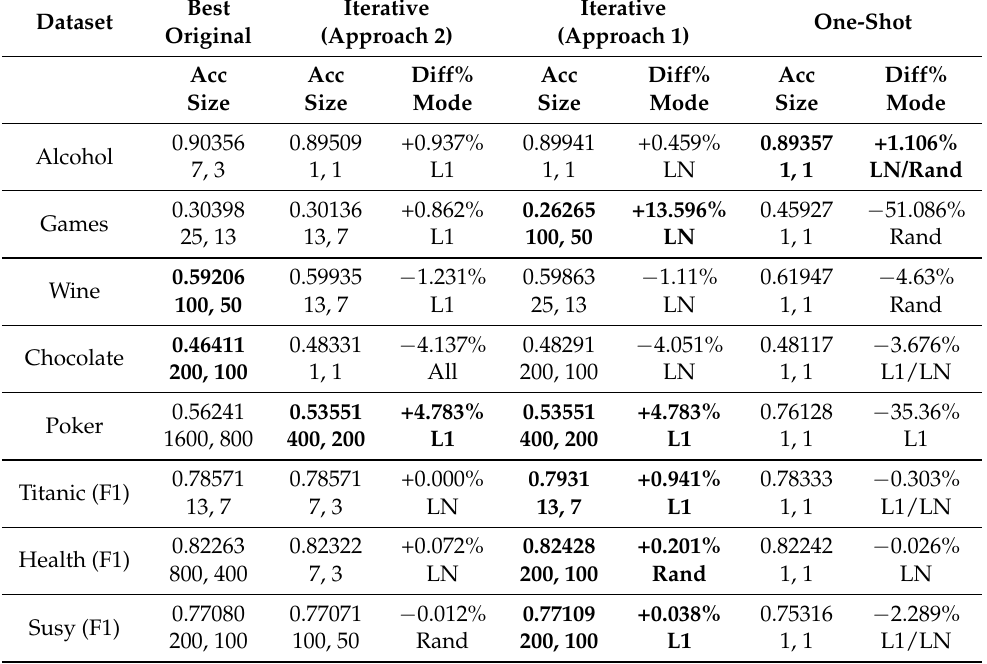
Table 4. Comparison of accuracy (RMSE/F1) for each dataset between the original tabular models, and iterative/one-shot modes. First result is the best performing original models, second result is best performing iterative when pruning the best original model (approach 2), third result is best performing iterative when pruning the largest model [1600, 800] (approach 1), and the final result is the best performing one-shot model. Results are shown in RMSE/F1 depending on the dataset along with the model size, then we include the difference in percentage along with the pruning mode for the model. Bold is marked as best performing